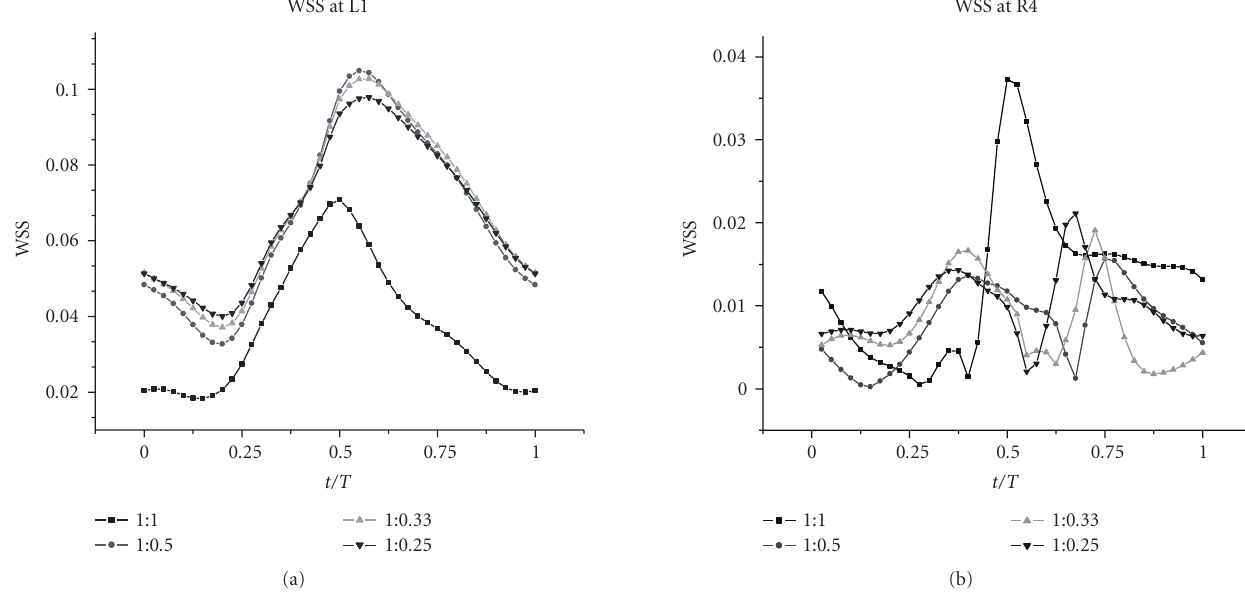
Figure 12: WSS on (a) the left and (b) the right impingement